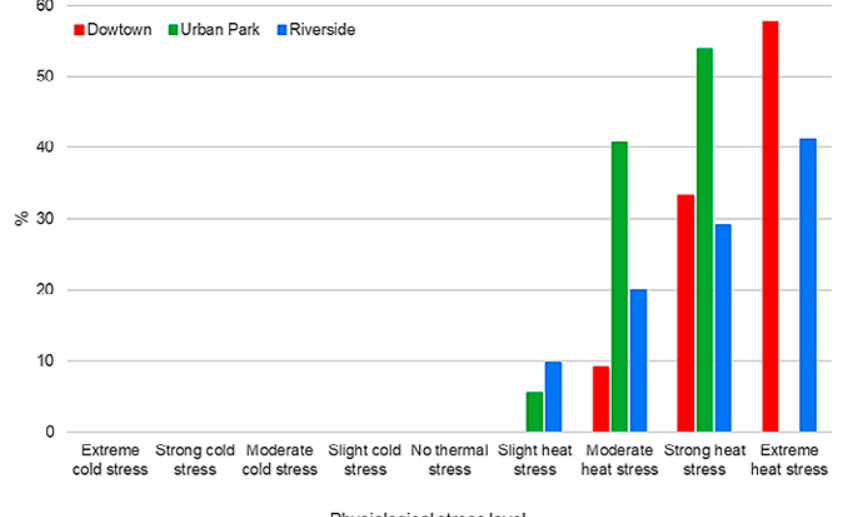
Figure 11. Frequency analysis (%) of different grades of physiological stress (based on mPET values) at locations in Banja Luka in period 22-24 June 2021 (measurement period 9-18 h